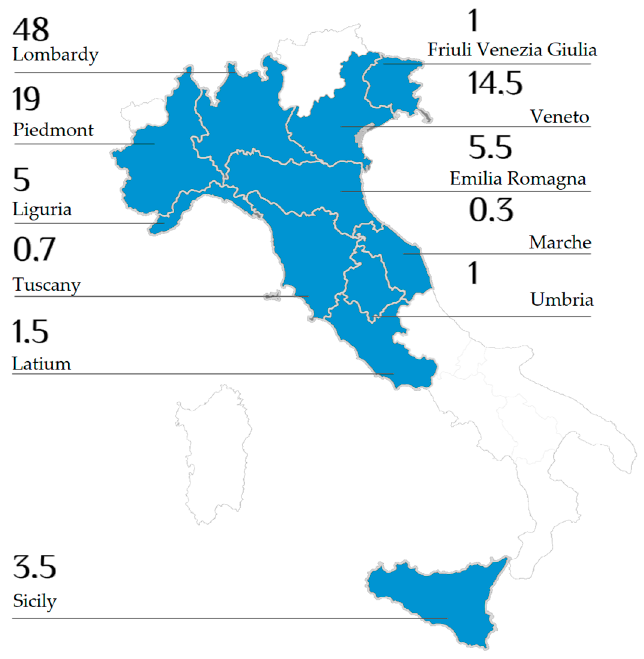
Figure 1. Geographic distribution of firms selected by region in Italy (in % terms).